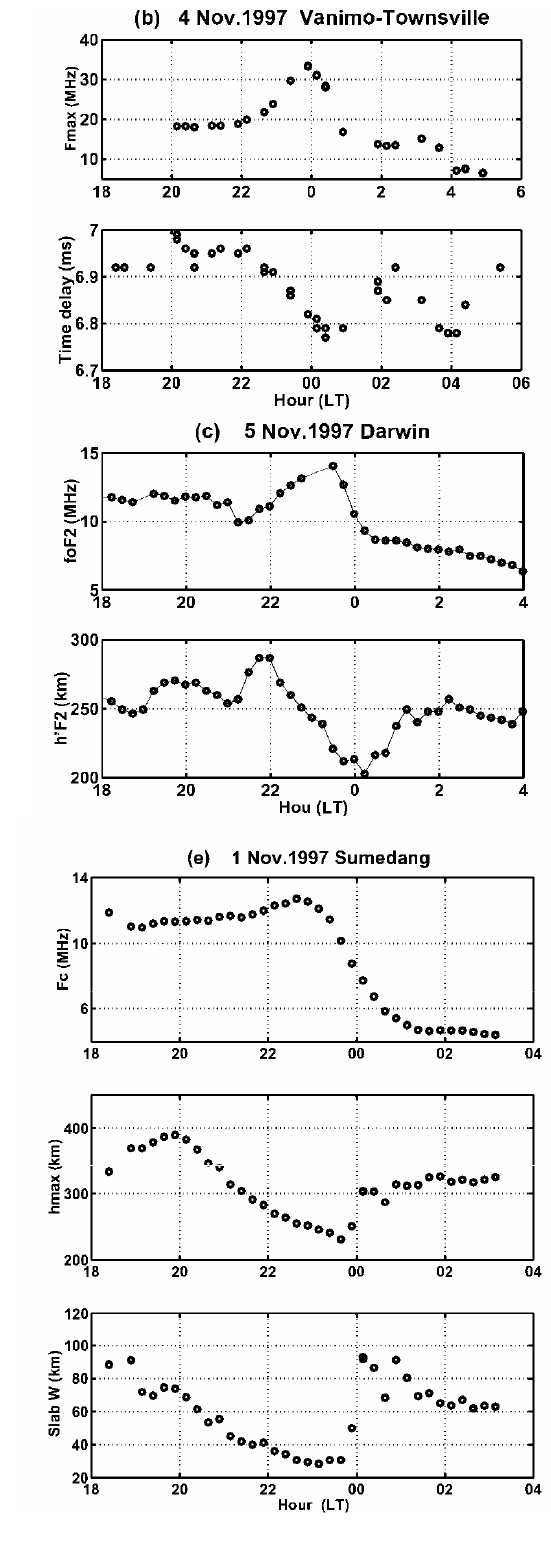
Fig.5. Fc, hmF2 and sub-peak slab width W measured at Vanimo, Sumedang and Fig. 5. Fc, hm F2 and sub-peak slab width W measured at Vanimo, Sumedang and Townsville. F max and time delay observed over the oblique path Vanimo-Townsville and fo F2 and h 0 F observed at Townsville. Fmax and time delay observed over the oblique path Vanimo-Townsville and FoF2 and h’F observed at Darwin.